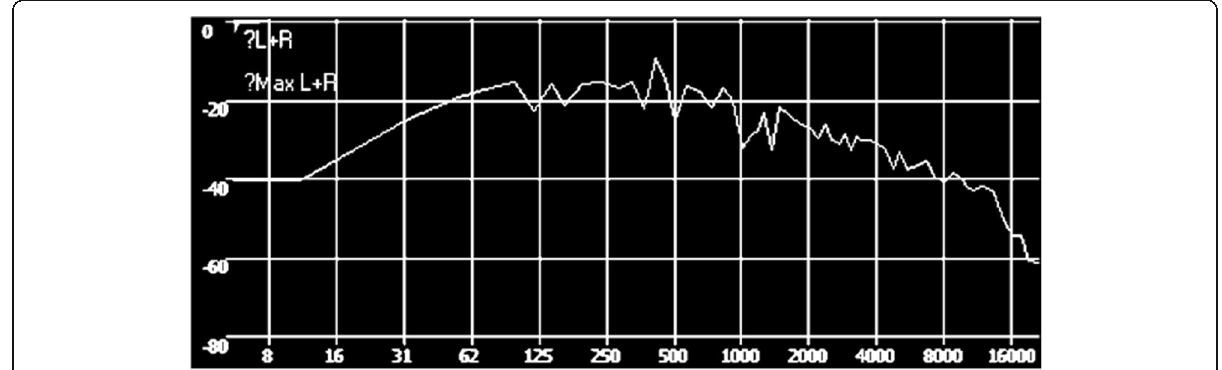
Fig. 5 The d sound image of small group two that Bart [a] uses vowel